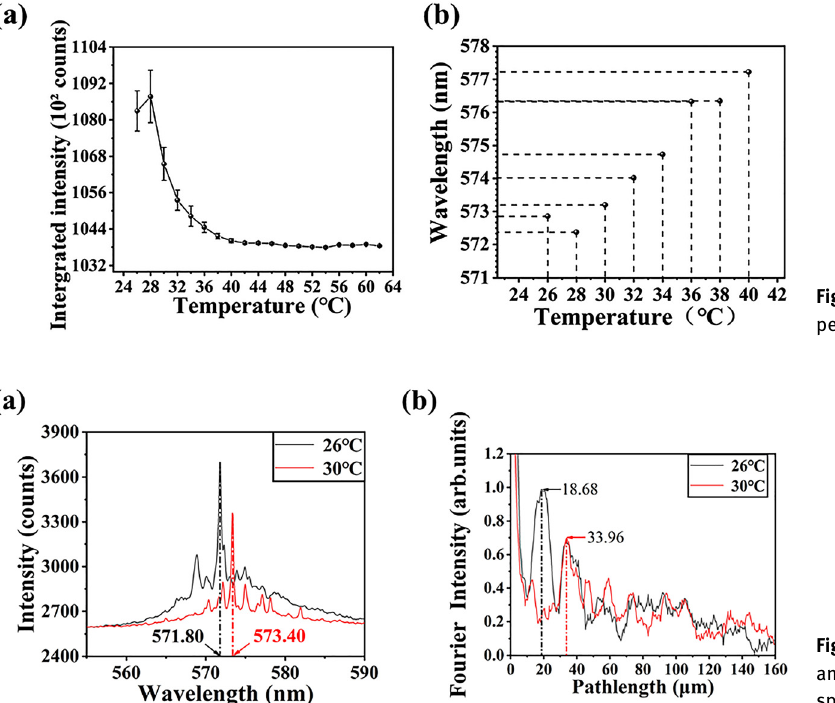
Figure 5: (a) Random lasing spectra at 26 and 30 ° C; (b) Fourier transform of the left